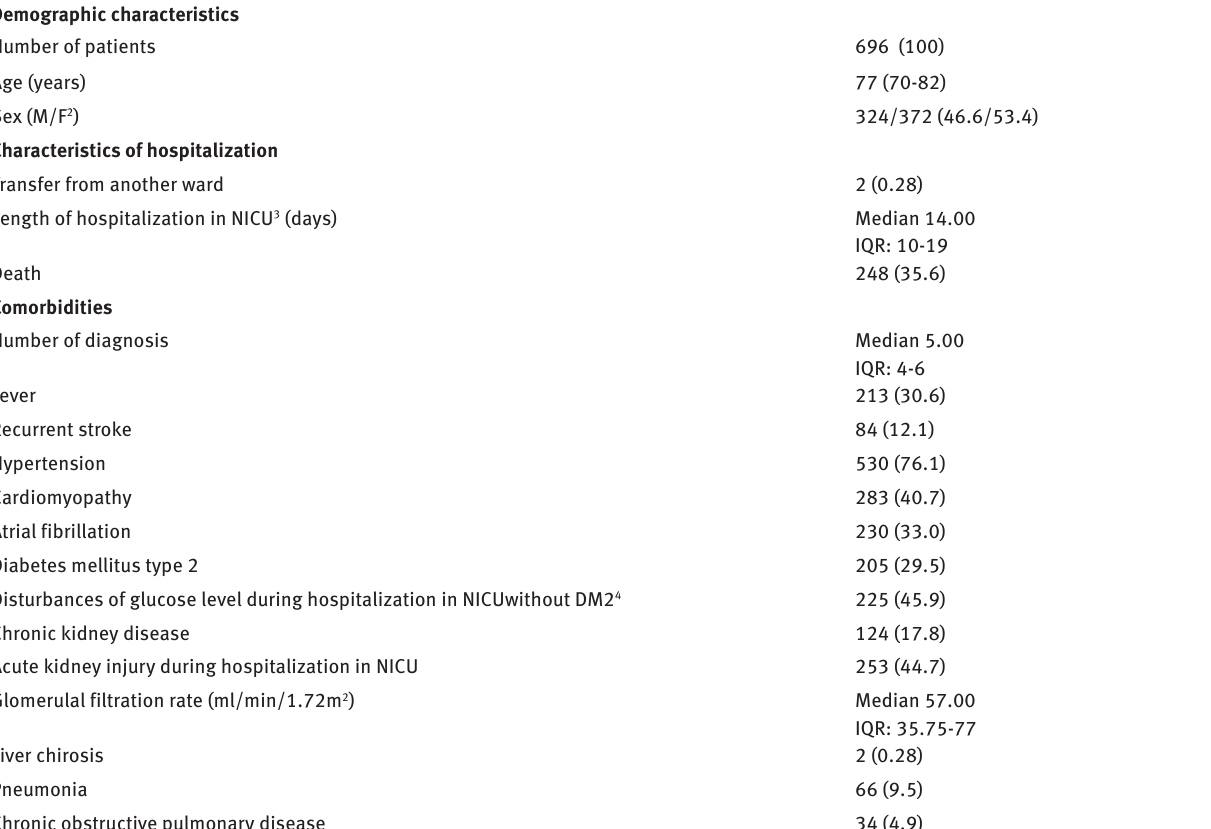
Table 1: Characteristics of cohort with acute ischemic stroke.